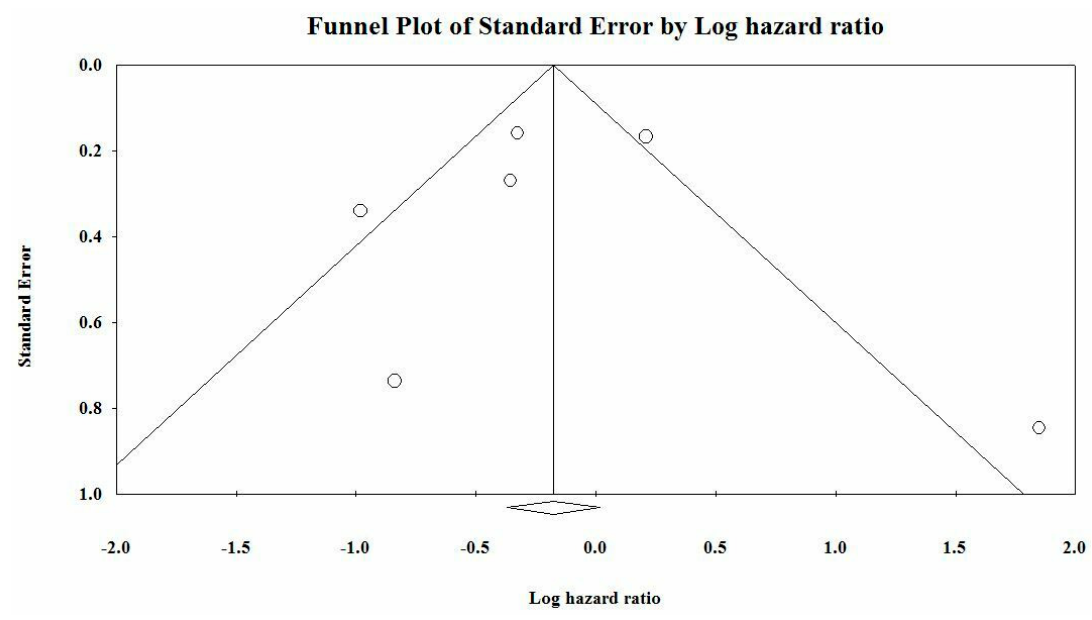
Figure 3. Funnel plot of the studies included in our meta-analysis.